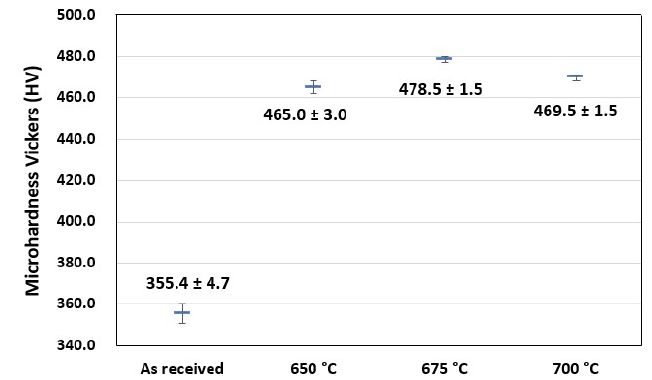
Figure 15. Vickers microhardness